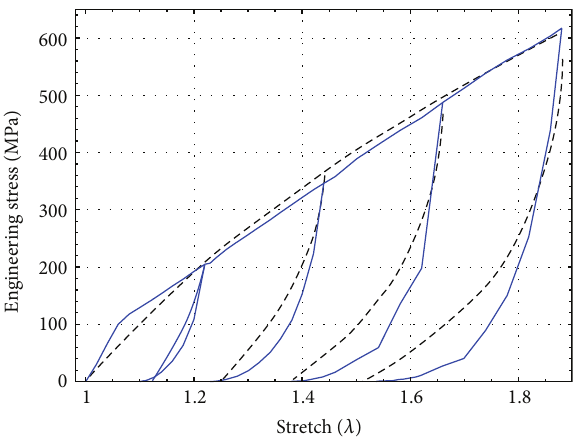
Figure 6: Engineering stress-stretch data for polydioxanone 4.0 compared with theoretical predictions of the nonmonotonous amended average-stretch, full-network model for which 𝜇 = 148 MPa, 𝑁 = 1.95 , 𝑏 = 0.445 , and 𝐶 = 0.0115 MPa. The dashed black lines represent theoretical predictions, and the blue solid lines describe experimental data.